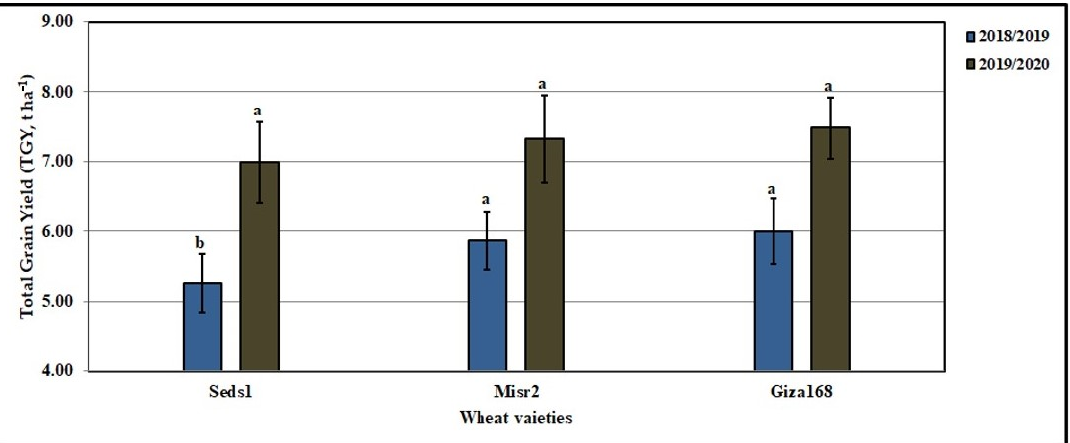
Figure 18. Influence of wheat varieties on total grain yield (TGY, t ha − 1 ) in clay loam soil in 2018/2019 and 2019/2020 seasons. Bars in the same years with a different letter indicate significant differences between treatments at p ≤ 0.01. HS 1, HS 2 , HS 3 represent HS applied as foliar spray at 1.0, 2.0, 4.0 g L − 1 , respectively, HS 4 , HS 5 , HS 6 represent HS applied as soil application at 5.04, 7.56, 10.08 kg ha − 1 .